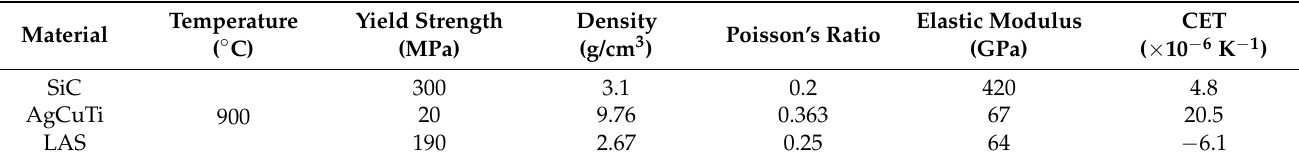
Table 3. Basic properties of materials used in the computations